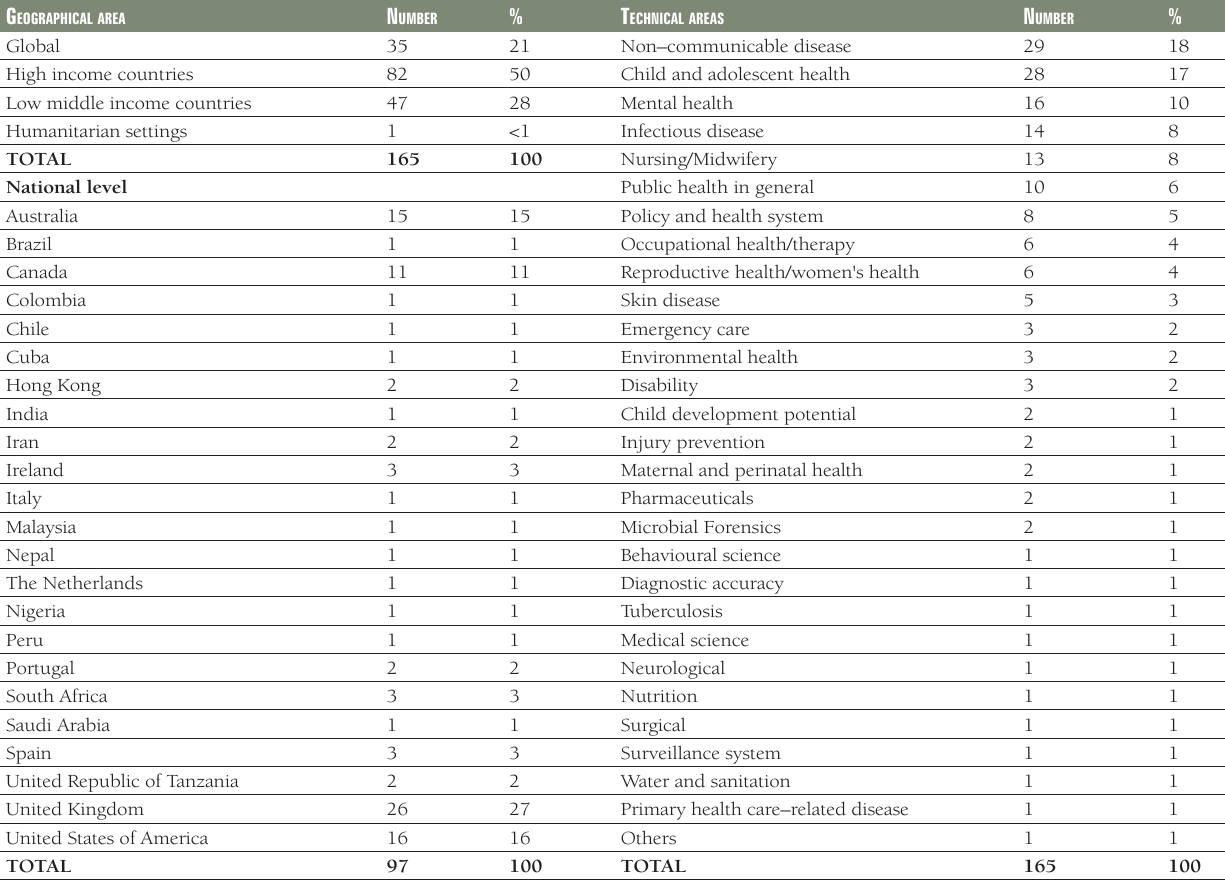
Table 7. Distribution of identified studies by geographic context and countries where the research priority setting exercises have been initiated and research priority areas